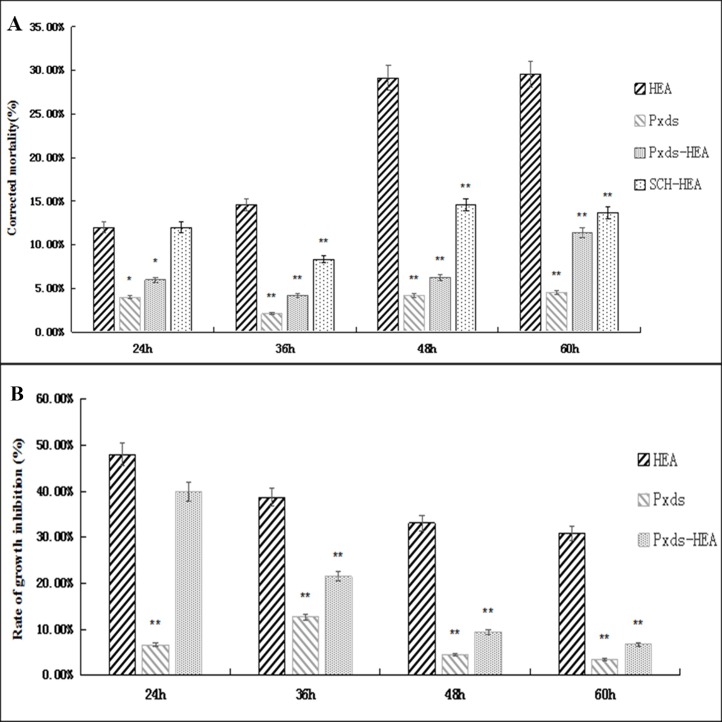
Impact of RNAi and Receptor Inhibitor on the insecticidal effect of HEA.Larvae were fed with dsRNA or receptor inhibitor (SCH58261) with or without HEA for a period of 24 h to 60 h. *P < 0.05; **P < 0.001 compared with the HEA group. (A) Effect of PxAdoR silencing and SCH58261 on the mortality induced by HEA. Corrected mortality (%) = (mortality of treatment−mortality of control)/(1−mortality of control)×100. (B) Effect of PxAdoR silencing on the rate of larvae growth. Rate of growth inhibition (%) = [(weight of control−weight of treatment)/ weight of control]×100.